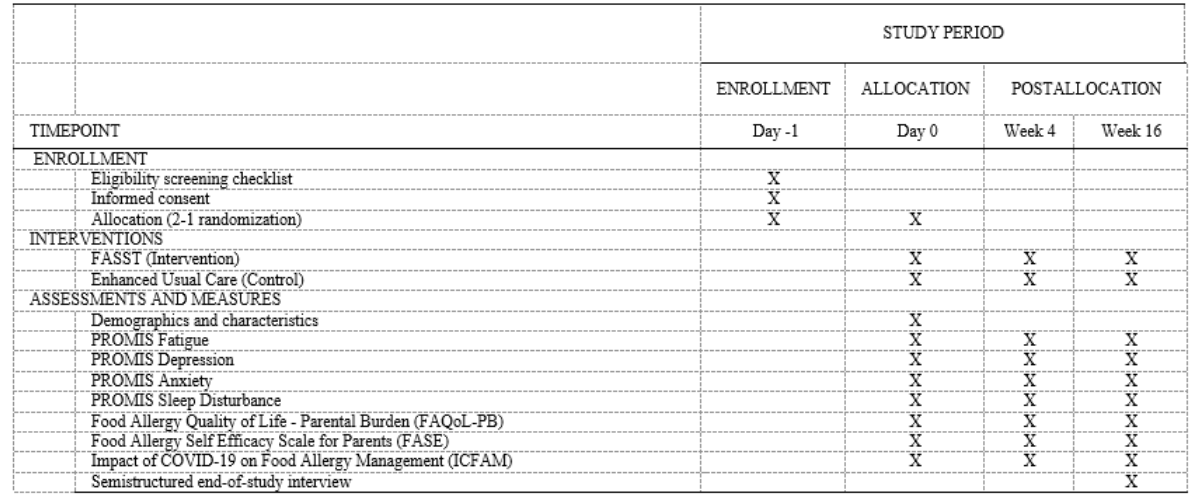
Figure 2. Study SPIRIT diagram. FASST: Food Allergy Symptom Self-Management with Technology for Caregivers; PROMIS: Patient-Reported Outcomes Measurement Information